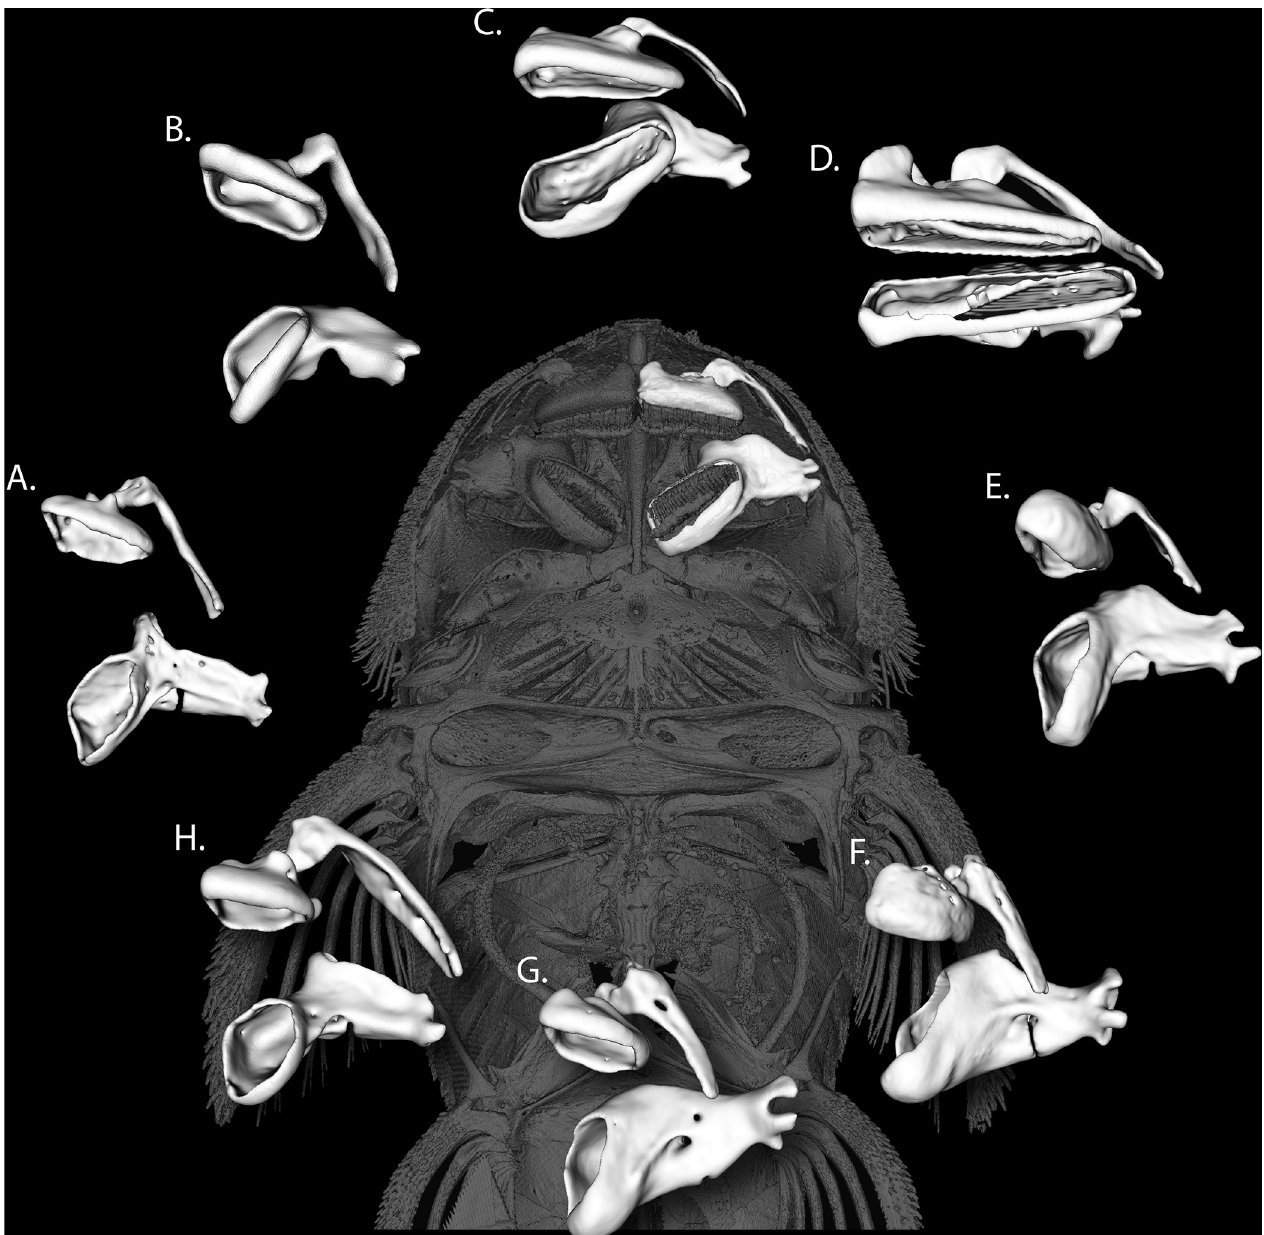
Fig 1. Oral jaw shape diversity in loricariid catfishes. The left oral jaws are shown in white. In the center, the placement of the oral jaws are shown for Baryancistrus xanthellus , MorphoSource ID: M37989-69325, Collection ID: ANSP 198216. Representatives of other species are as listed; A) Otocinclus vittatus , M39000-70695, ANSP 174732, B) Farlowella acus , M37599-68848, ANSP 191381, C) Harttia loricariformis , M44340-80321, ANSP 190961, D)